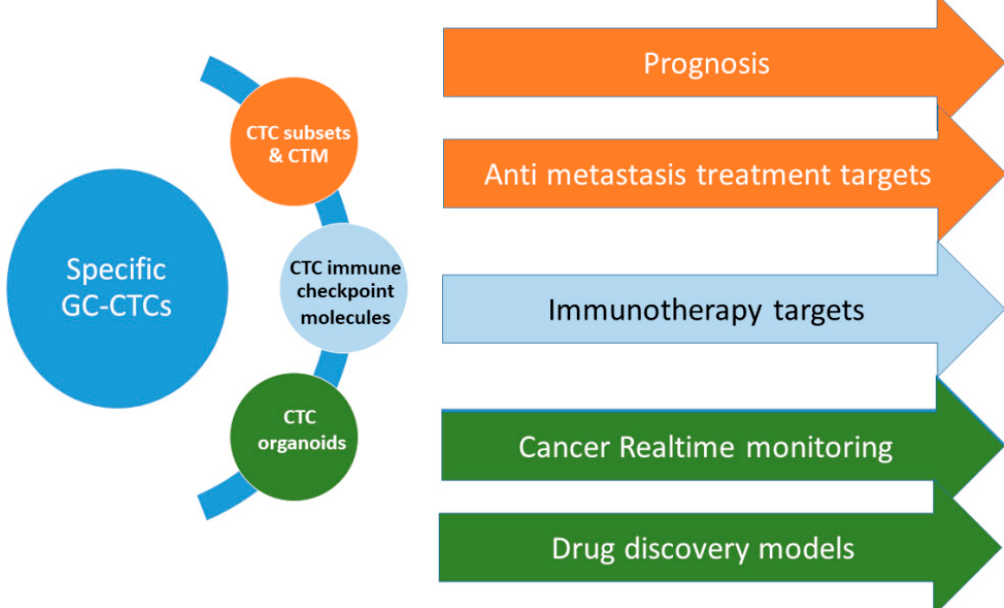
Figure 2. The future perspectives of CTCs in gastric cancer. Understanding GC-CTCs signatures would facilitate the use CTC subpopulations and CTMs in GC prognosis and as potential targets in anti-metastasis treatment; the use of immune checkpoint molecules on CTC surface as targets for GC immunotherapy; and the use of CTC organoids in cancer real-time monitoring and as in vitro and in vivo models for drug discovery.